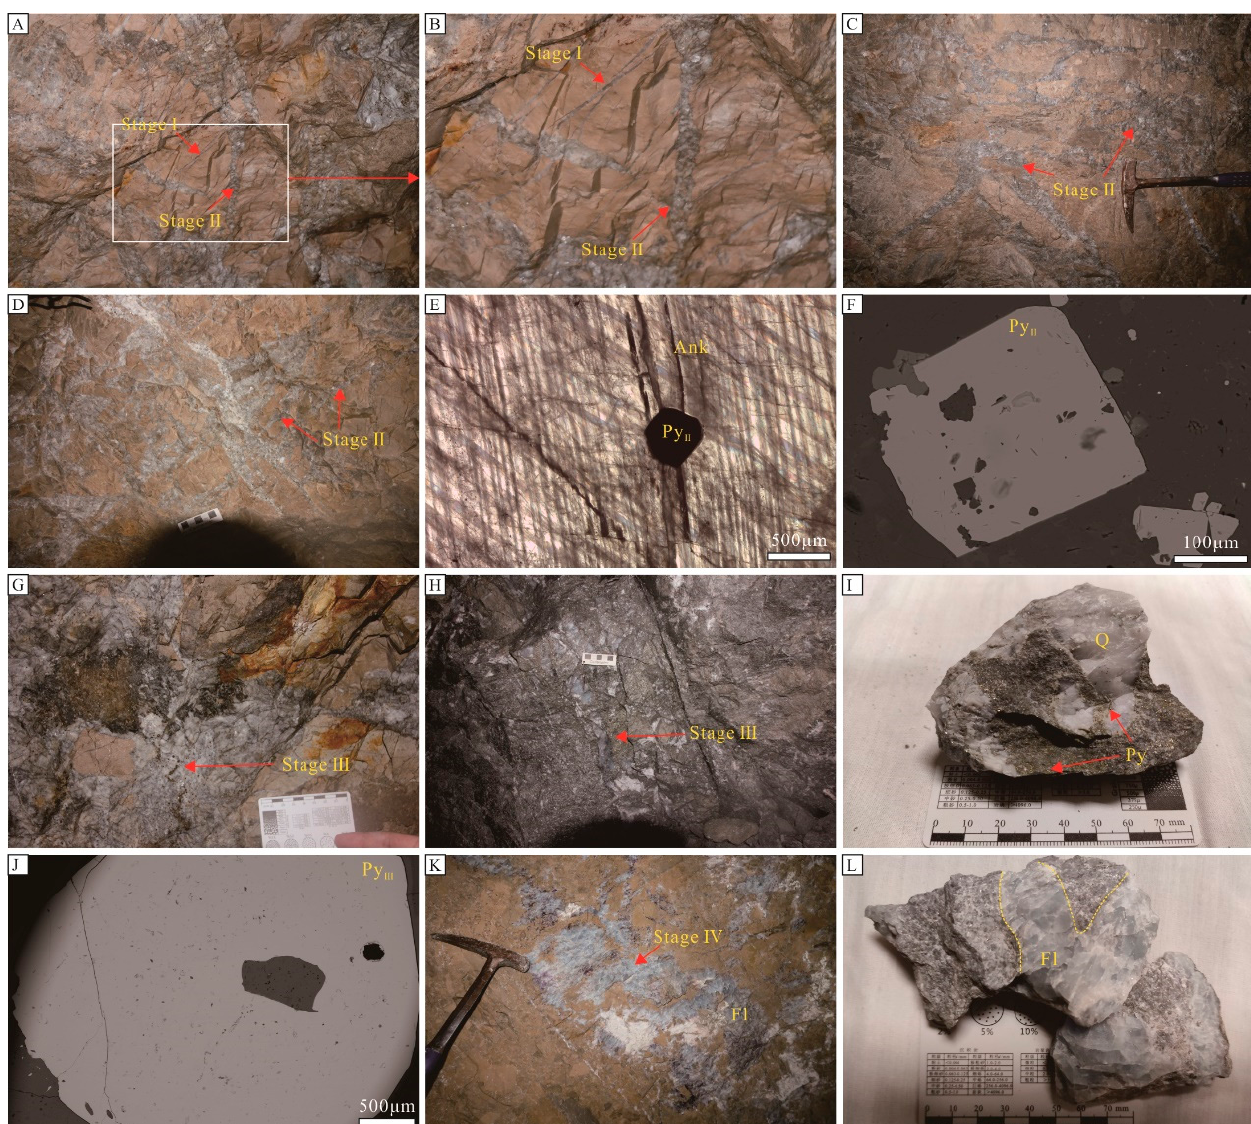
Figure 5. Metallogenic stages and characteristics of the Shuangwang gold deposit. ( A – D ) Fine veins of quartz and albite entered into albitite in stage Ⅰ and ankerite–pyrite–albite assemblage formed in stage Ⅱ ; ( E , F ) Gold-bearing pyrite occurs as fine grains, disseminated in euhedral or subhedral ankerite formed in stage Ⅱ ; ( G – I ) Pyrite–quartz–calcite stage assemblage formed in stage Ⅲ ; ( J ) Pyrite without gold occurs as euhedral, medium-coarse grain in quartz-calcite veins; ( K , L ) fluorite-anhydrite assemblage formed in stage Ⅳ .